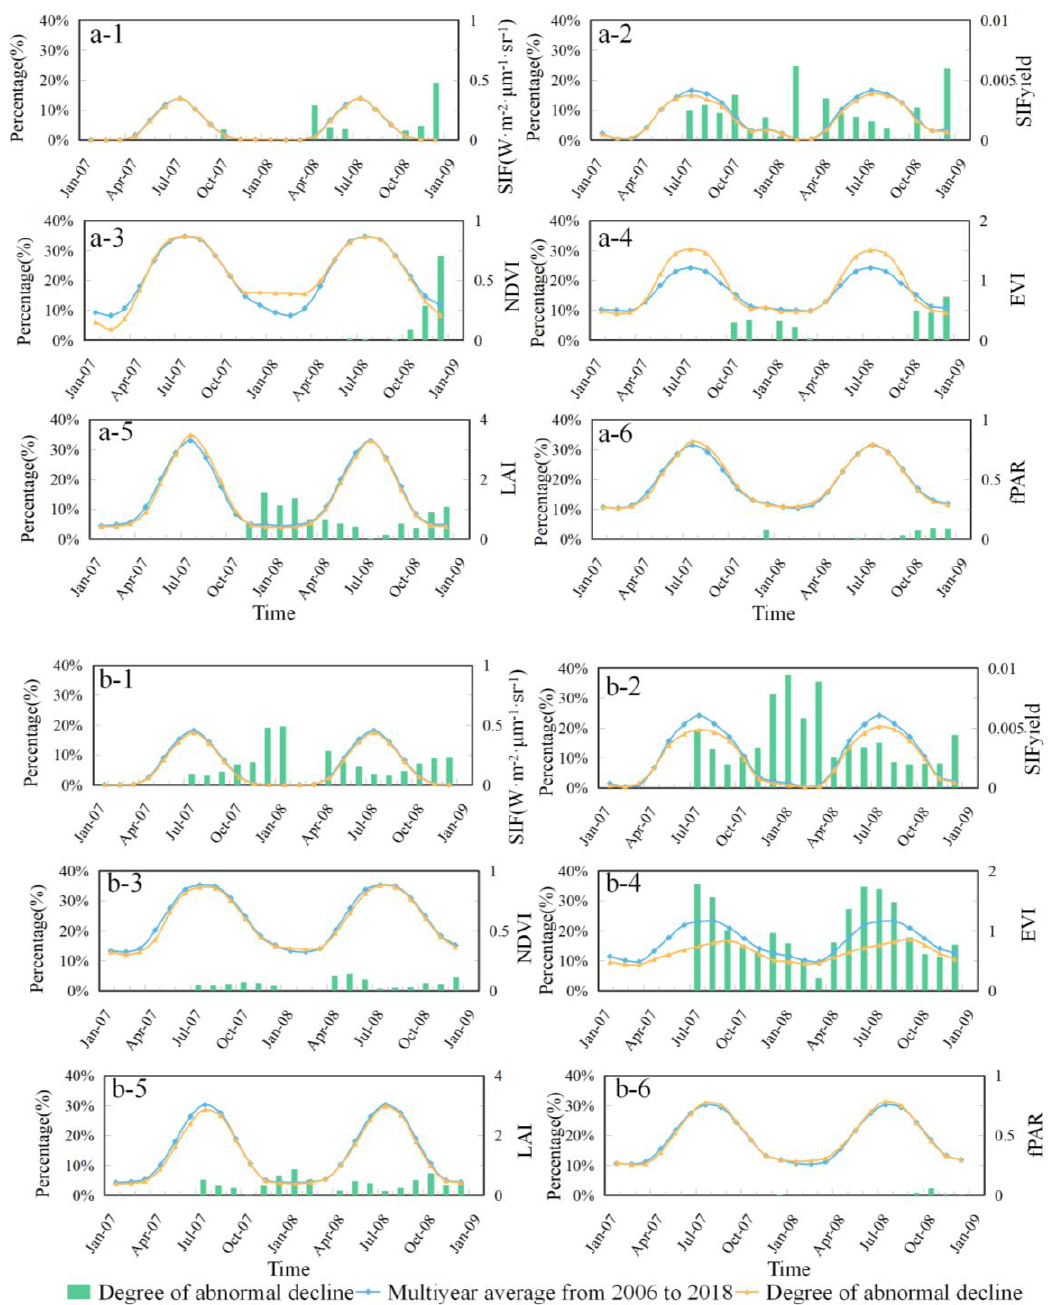
Figure A3. ( a1 – a6 ) The seasonal cycle variation curves of present values and multi-year averages and the abnormal decrease amplitude of the present values from the average values of SIF, SIFyield, NDVI, EVI, LAI, and fPAR, respectively, of the cold-temperate coniferous forest region in Heilongjiang province ( b1 – b6 ). The seasonal cycle variation curves of present values and multi-year averages and the abnormal decrease amplitude of the present values from the average values of SIF, SIFyield, NDVI, EVI, LAI, and fPAR, respectively, of the temperate coniferous and deciduous broad-leaved mixed forest region in Heilongjiang province.